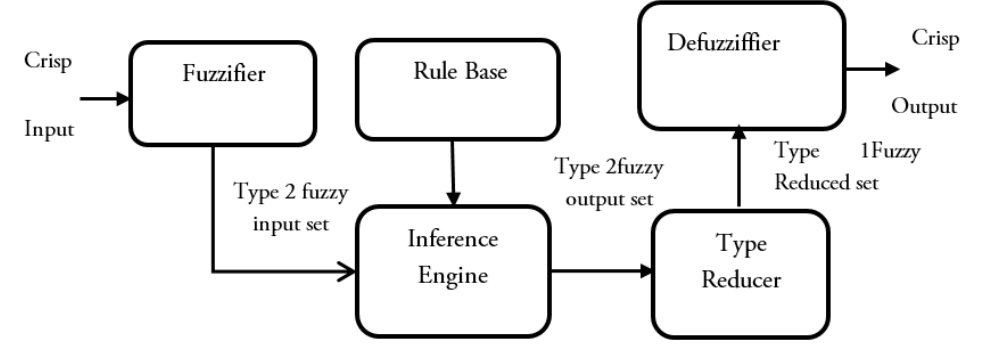
Fig. 3. The structure of a type -2 fuzzy logic system